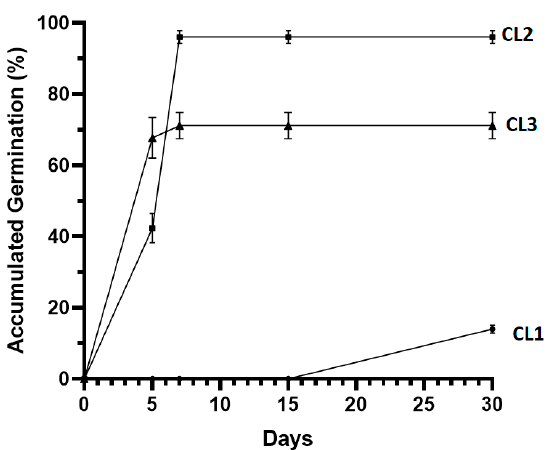
Figure 7. Effect of seed scarification on cumulative germination of A. pelegrina grown in vitro. CL1: control (intact, whole seed); CL2: transverse cut of the seed at the apex (opposite side of the hilum) to a depth of 0.1 to 0.5 mm; CL3: transverse cut at the apex (opposite side of the hilum) to a depth of 0.5 to 1 mm with embryo exposure. The bars represent the standard error.